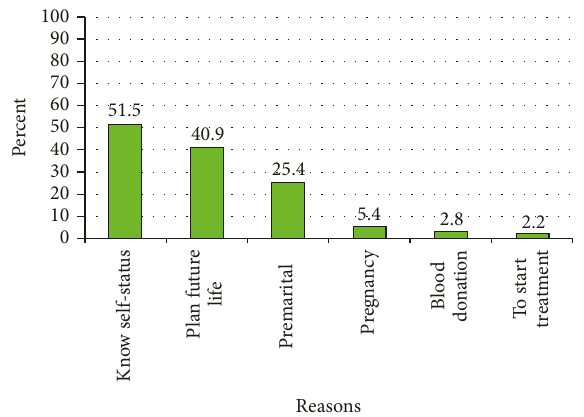
Figure 3: Reason mentioned to get tested for HIV among secondary school teachers in Awi Zone, Amhara Region, 2014.